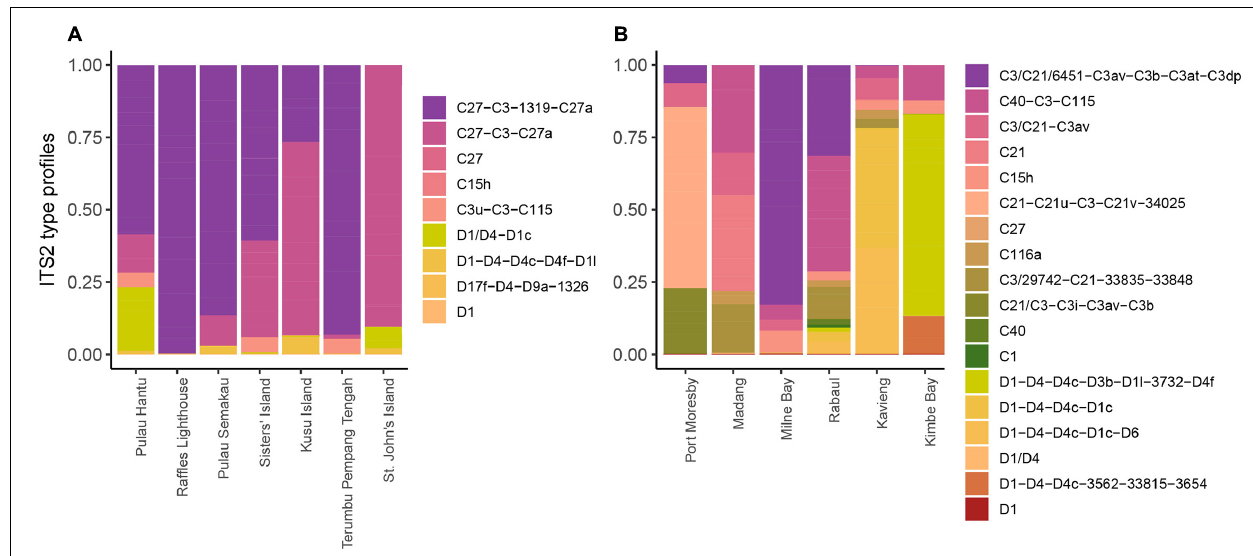
FIGURE 4 | Diversity and relative abundances of Symbiodiniaceae ITS2 type profiles among the sites studied in (A) Singapore and (B) Papua New Guinea.